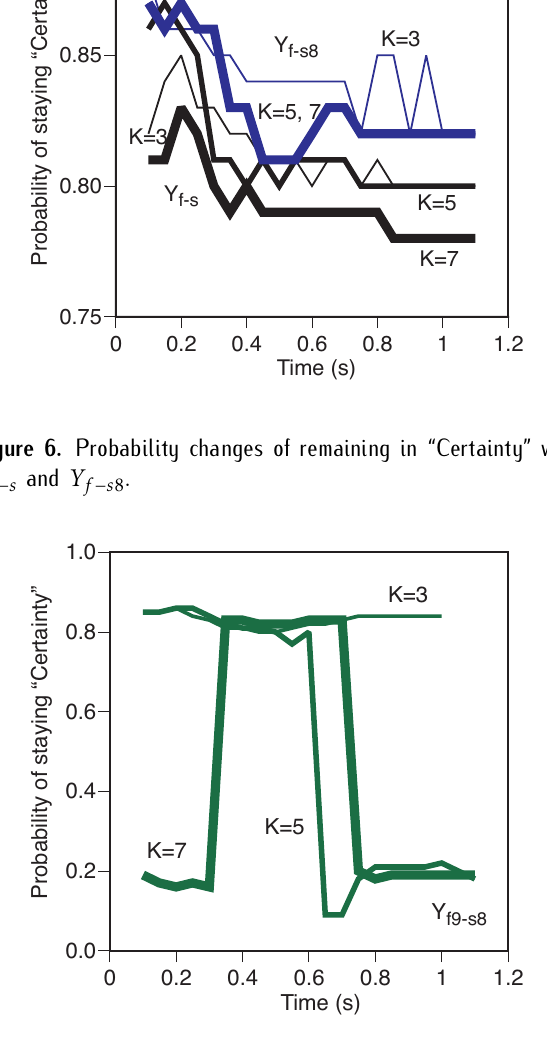
Figure 7. Probability changes of staying in “Certainty” with Y f 9 (cid:0) s 8